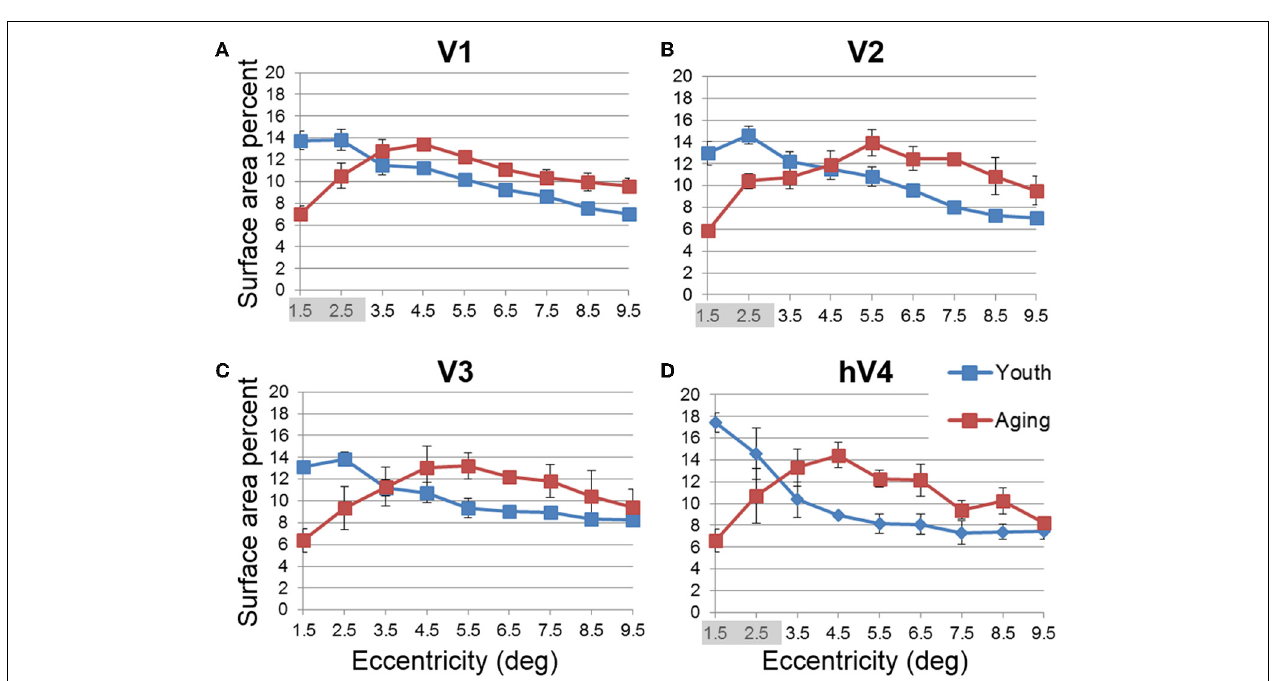
represents data measured in individual subjects and averaged across both of each subject’s hemispheres. Surface area percent is plotted as a function of degrees of eccentricity from 1 to 10 ◦ eccentricity (bins centered on 1.5–9.5 ◦ ). Note the consistency for both the youthful and healthy aging subjects. Note also the different distribution for AD-S10 relative to the other subjects.